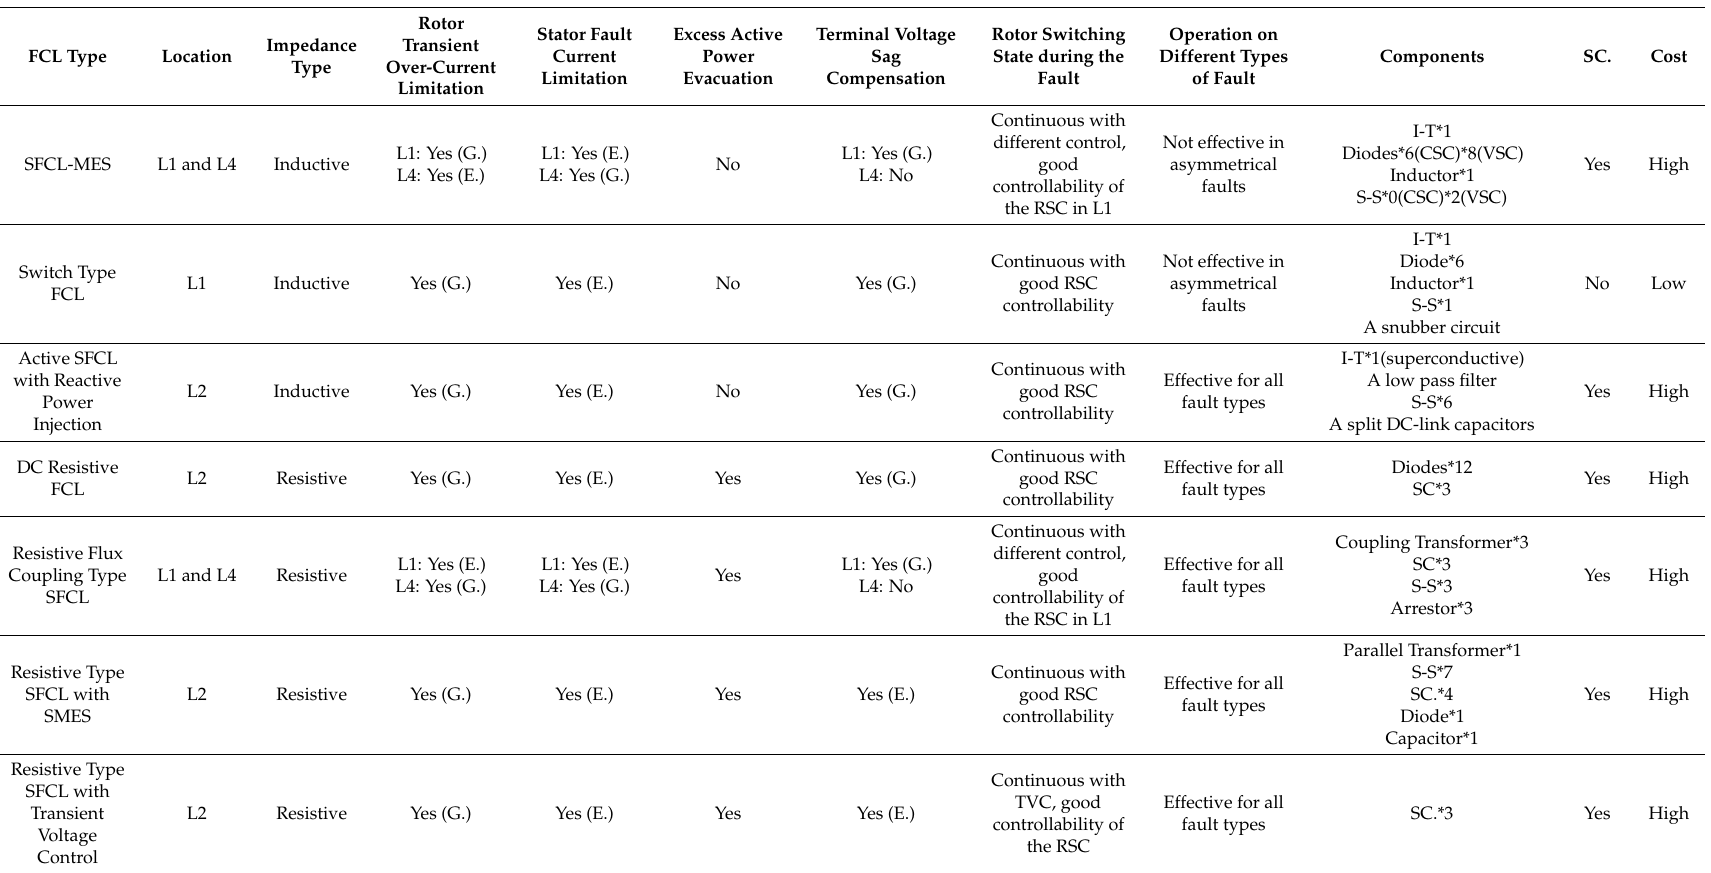
Table 1. A summary of characteristics of the fault current limiting